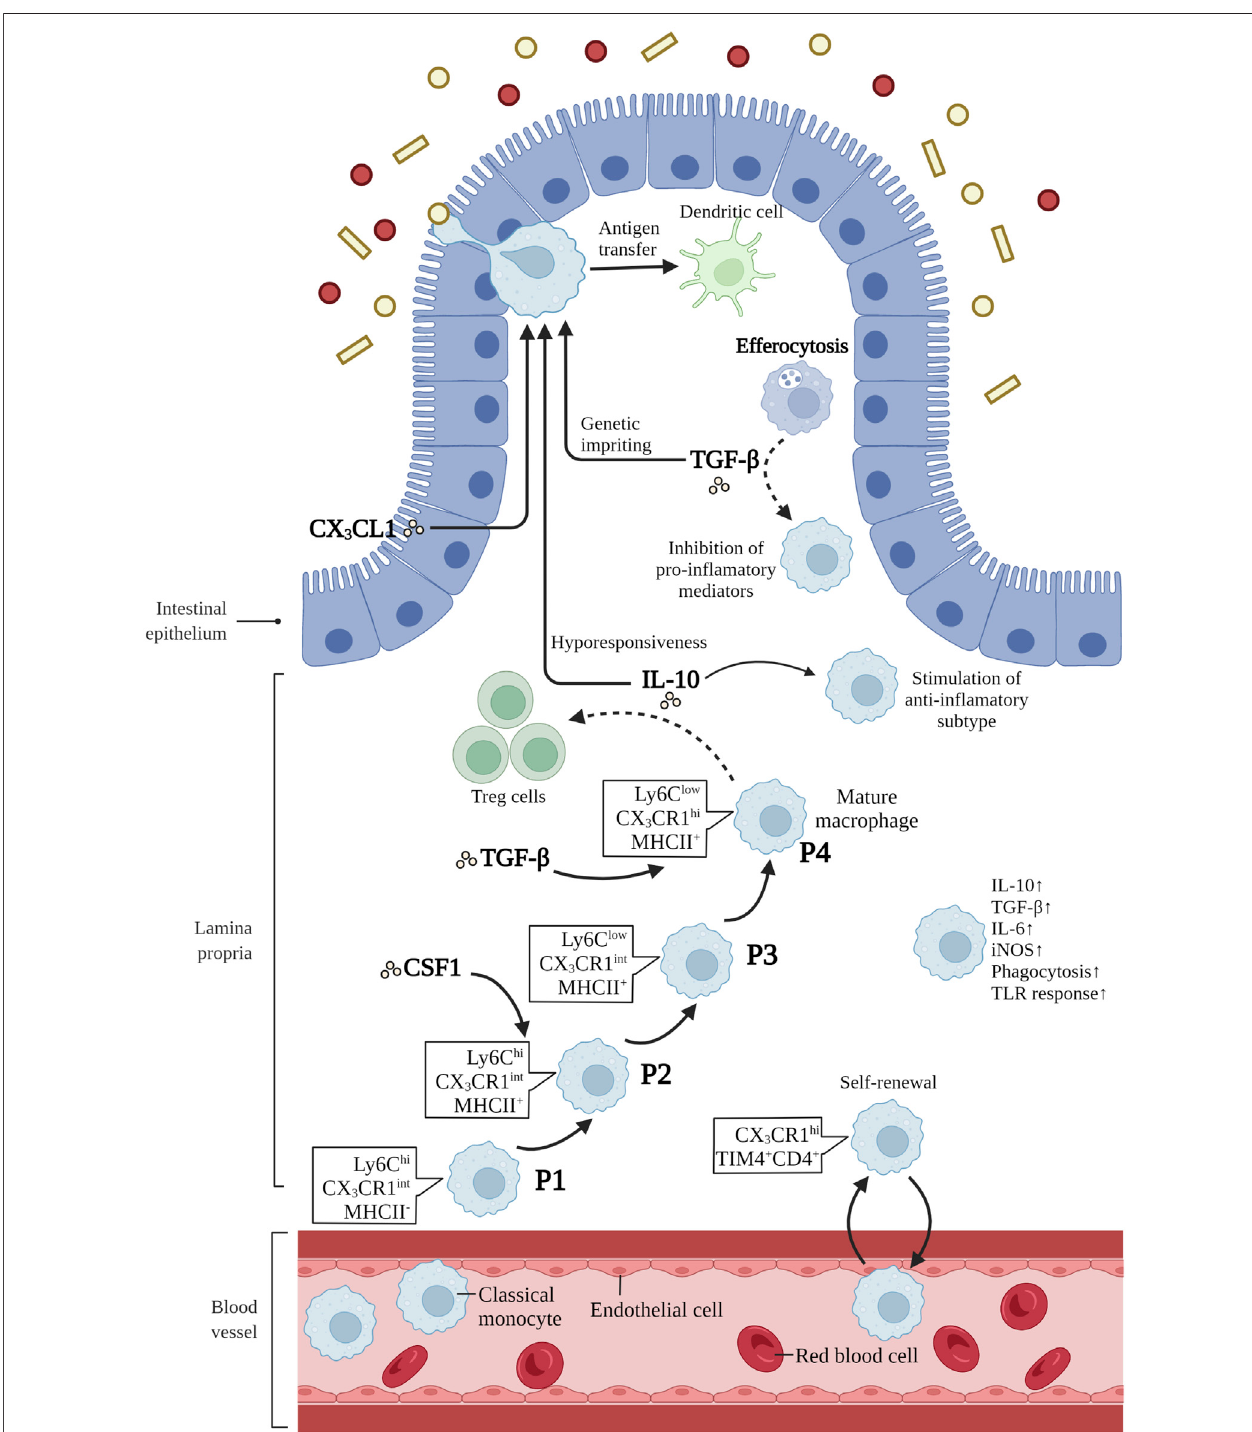
FIGURE 1 | Differentiation and function of intestinal macrophages. Intestinal macrophages are replenished by blood-derived monocytes through a series of differential intermediates in a way of “ monocyte waterfall ” . lymphocyte antigen 6C-high (Ly6C hi ) CX3C-chemokine receptor 1-intermediate (CX 3 CR1 int ) major histocompatibility complex II (MHCII − ) (P1) monocytes enter the lamina propria, acquiring the expression of MHCII (P2), and then downregulating Ly6C expression (P3). Finally, these cells upregulate the expression of CX 3 CR1, CD64, and F4/80, giving rise to mature macrophages (P4). T cell immunoglobulin mucin receptor 4- positive (Tim-4 + ) CD4 + macrophages have been demonstrated to be long-lived and locally self-renewed independent of monocytes. Macrophage colony-stimulating factor 1 (CSF1) is a critical cytokine in the survival, proliferation and differentiation of intestinal macrophages. IL-10 is crucial in inducing subtype of anti-in fl ammatory